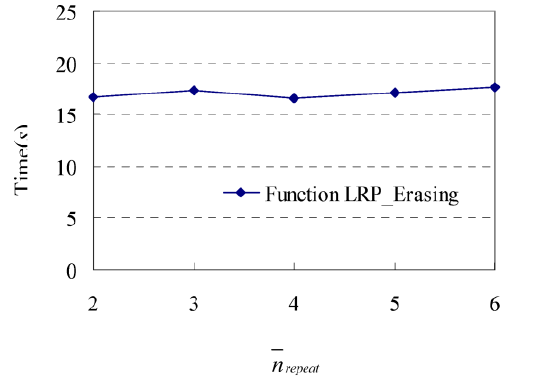
Figure 13. Execution time in response to changes in different